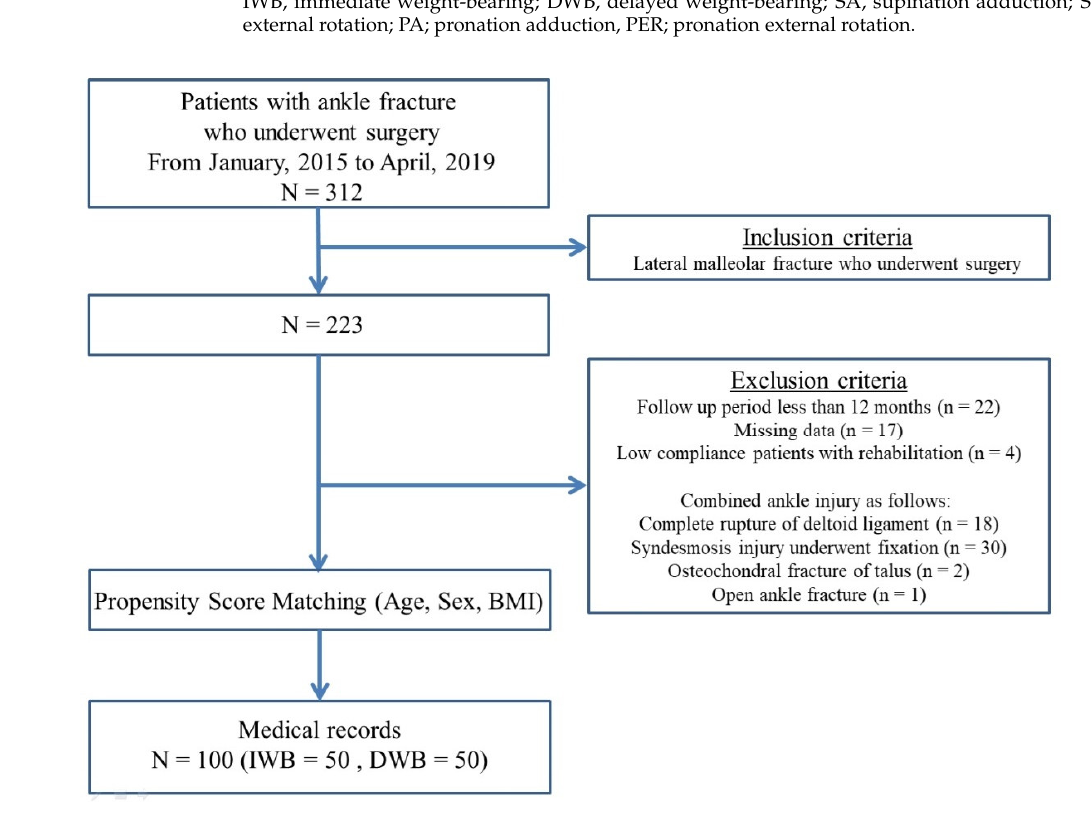
Figure 1. Flow chart of the study population.